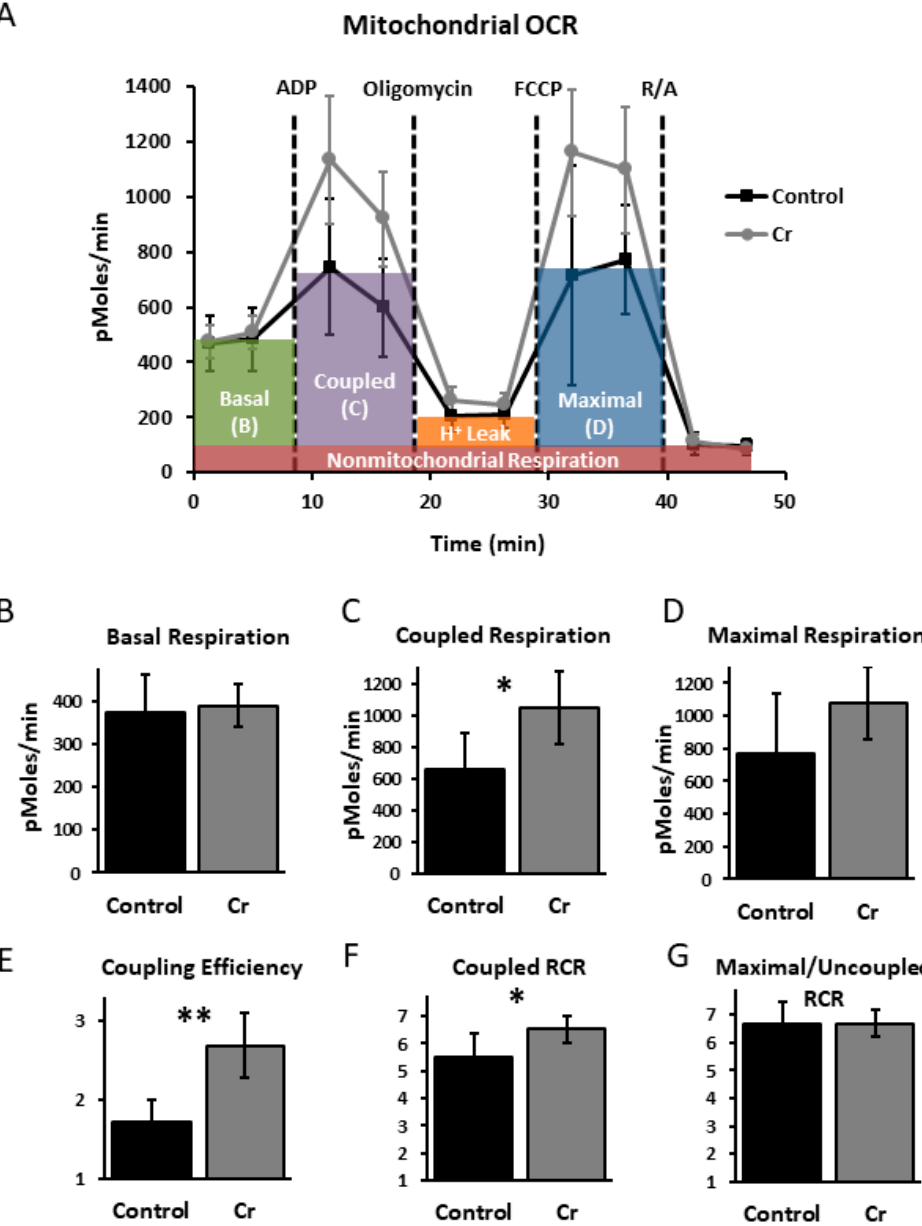
Figure 5. Oxygen consumption rates (OCR) in mitochondria isolated from the hippocampus in control and Cr-supplemented 3xTg mice. ( A ) Representative kinetics graph indicating real-time OCR at baseline and after addition of substrates adenosine diphosphate (ADP), oligomycin, carbonyl cyanide p -trifluoromethoxy-phenylhydrazone (FCCP), and rotenone-antimycin (R / A) in 10 µ g of mitochondrial protein / well. ( B ) Basal respiration, ( C ) coupled respiration, and ( D ) maximal respiration (mean ± SD) were calculated after subtracting non-mitochondrial respiration (after R / A) and compared between control and Cr-supplemented mice. ( E ) Coupling e ffi ciency was calculated by dividing coupled respiration (after addition of ADP) by basal respiration. ( F ) Coupled respiratory control ratio (RCR) was calculated by dividing coupled respiration rates (after ADP) by OCR after oligomycin. ( G ) Maximal or uncoupled RCR was calculated by dividing maximal respiration rates (after FCCP) by OCR after oligomycin. Cr supplementation selectively increased coupling-associated parameters in isolated mitochondria from both female and male 3xTg mice. Student’s t -test or Mann-Whitney U (MWU); n = 5 wells / group; * p < 0.05; ** p <